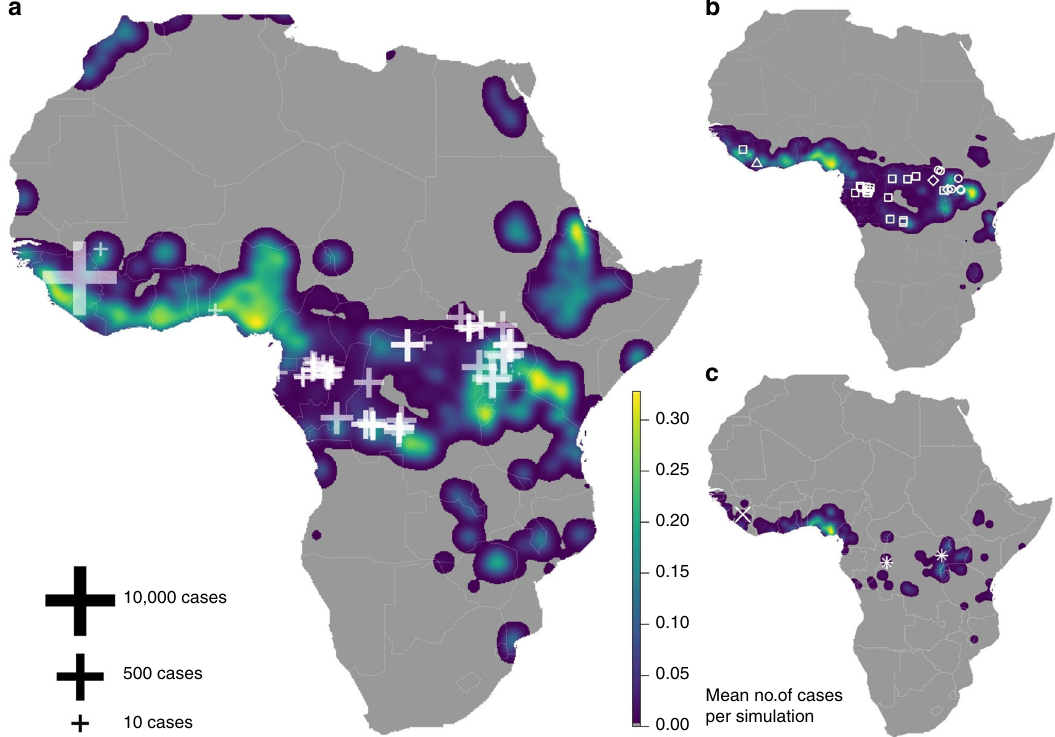
Fig. 3 Present day risk of EVD cases caused by Zaire Ebola virus (EBOV) from EMM simulations. Maps represent the mean number of EVD-EBOV cases between zero (dark blue) and 0.3 (yellow) per grid cell (0.0416° — 5.6 km at equator) across 2500, 365-day simulation runs for the present day, where ( a ) shows all cases (both index and secondary), ( b ) index cases only, and ( c ) index cases from epidemics (1500 + cases). White crosses in ( a ) represent log outbreak size. White symbols in ( b ) represent all locations of known EVD index cases from different viral strains, where circles represent Zaire (EBOV), square Sudan (SUDV), triangles Taï Forest (TAFV), and tetrahedrons Bundibugyo (BDBV). Diagonal white cross in ( c ) represents location of index case from 2014 – 2016 epidemics, white stars the locations of Ebola outbreaks that have occurred since the modelling was